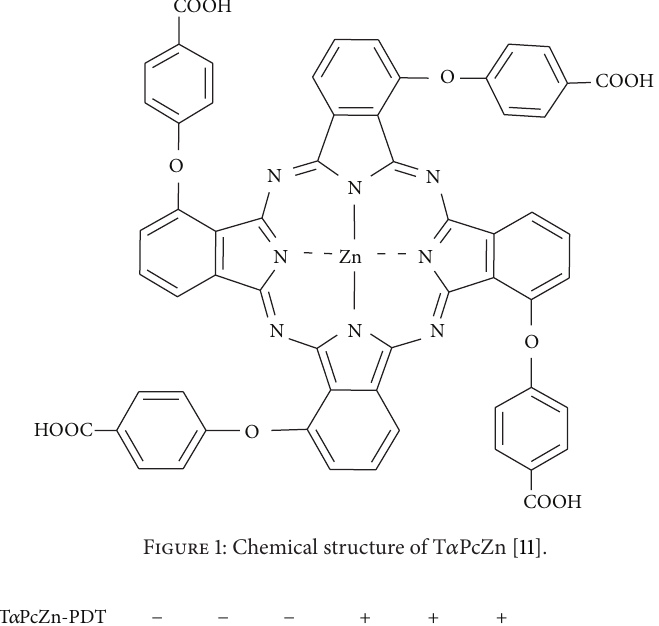
Figure 1: Chemical structure of T 𝛼 PcZn [11].